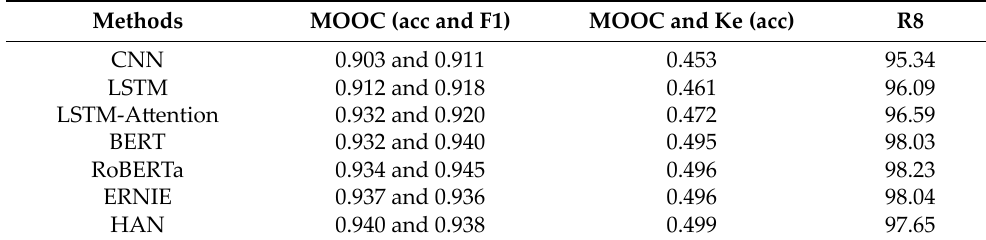
Table 3. Comparative experimental